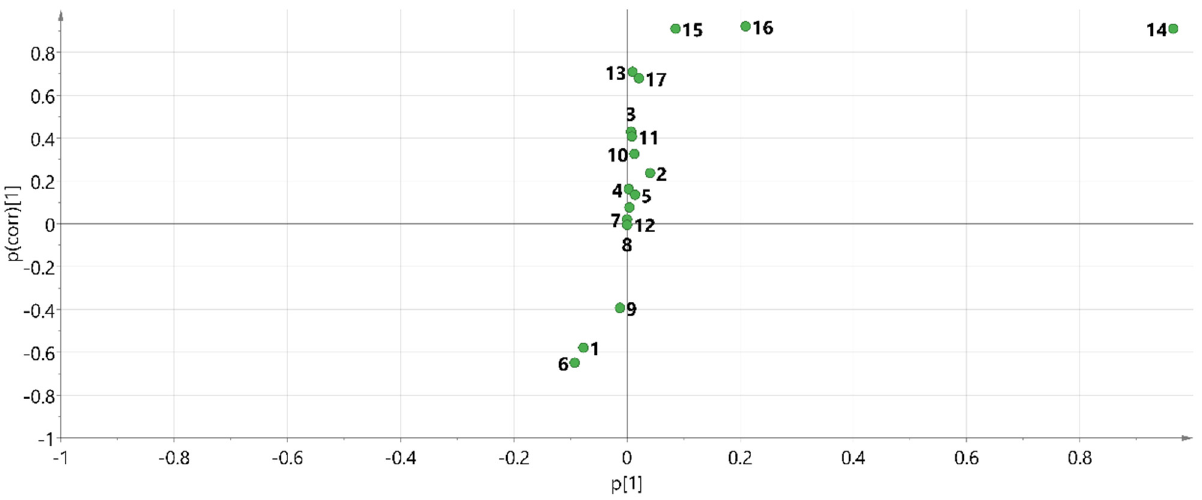
Figure 6. VIP diagram of 27 batches of AMR sample.